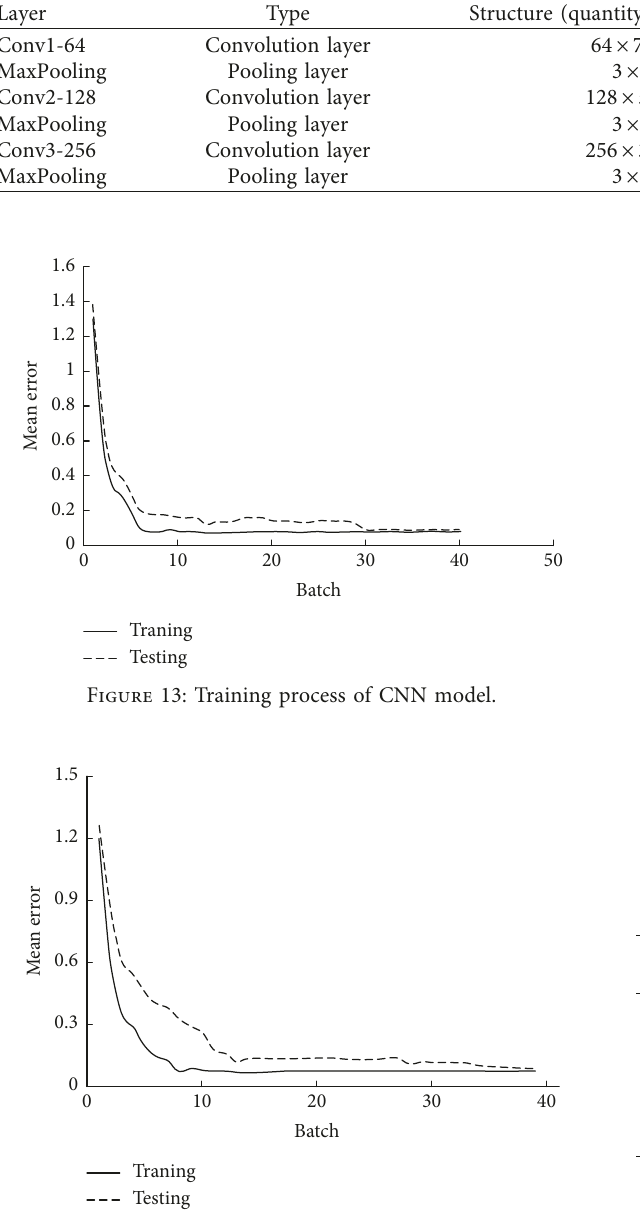
Figure 14: Training process of BP model.